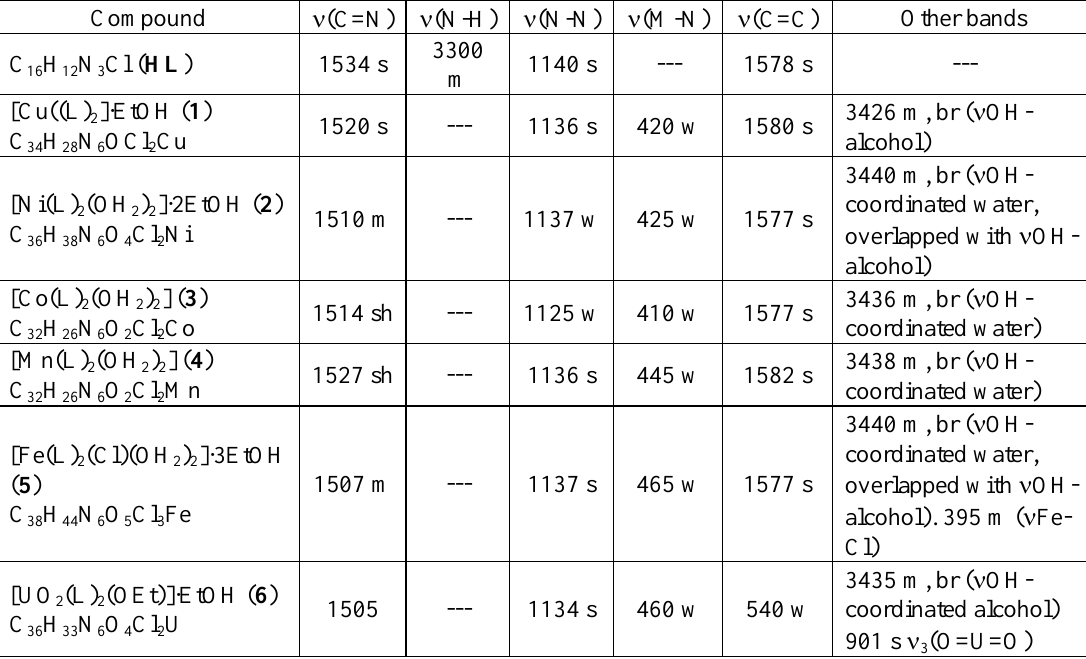
Table 3. Characteristic IR bands (cm -1 ) of the ligand HL and its metal